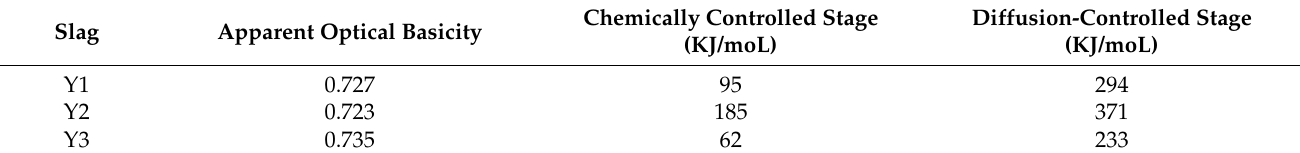
Table 6. The apparent optical basicity and activation energies of the lead-rich slags.